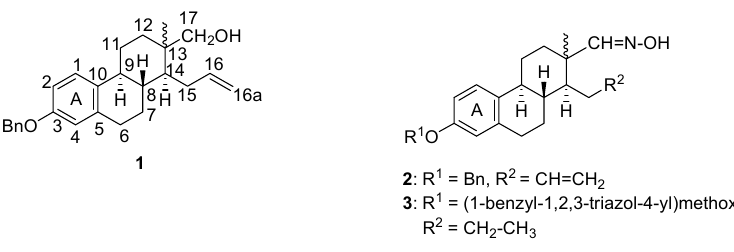
Figure 1. Structures of the potent antiproliferative D -secoestrones 1 and 2 , 3 .